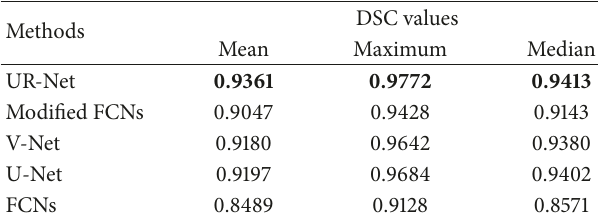
Table 1: Quantitative evaluation results of the segmentation meth-